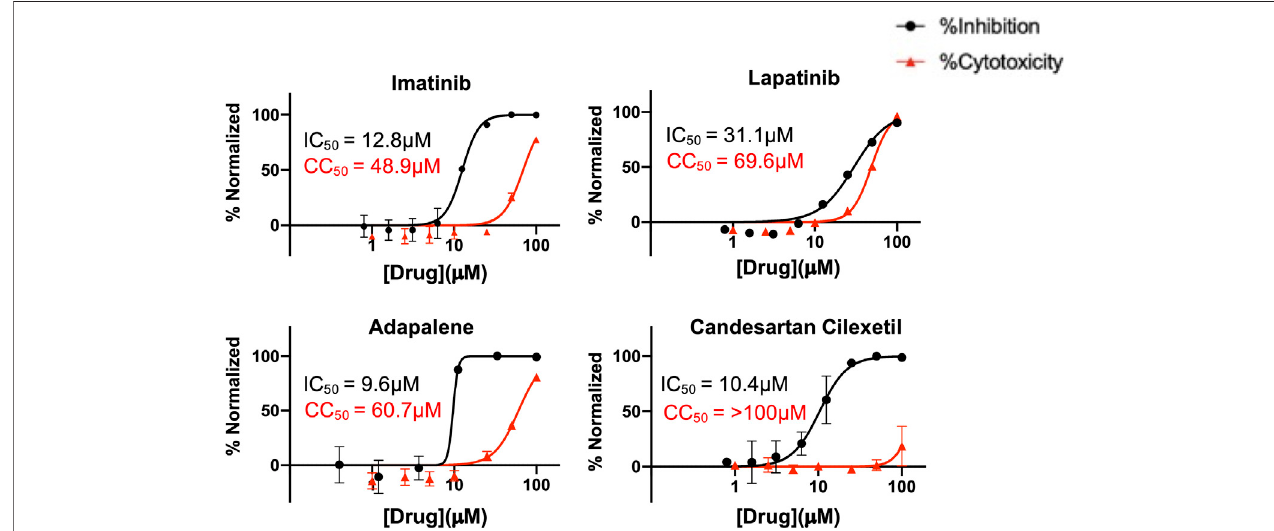
FIGURE6| PercentageinhibitionandpercentagecytotoxicitygraphsformSARS-CoV-2infectionstudiesthatshowlargetherapeuticindexesinthreehits.Varying concentrations of imatinib, lapatinib, and adapalene were used to treat virus for 30 min prior to infection in Vero cells, while candesartan cilexetil was added directly to cells without pre-treatment to virus. Infections were performed using SARS CoV-2mNeon at an MOI of 0.2. At 1 h post-infection, the media was removed and replaced with fresh media. Fluorescent reporter values were recorded 18 h post-infection. Similarly, Vero cells were treated with varying concentrations of indicated drugs, incubated for18 hpriortoanalysisbyPresto-Blue assaystoassess cytopathic effect.Datawerenormalized topercentinhibitionorpercentcytotoxicityfordrug-treated cells vs. no-treatment control. The values are means, with error bars displaying standard deviation between the triplicate wells. Half-maximal inhibitory concentration (IC 50 ) curves and values are represented in black while half-maximal cytotoxicity concentration 50 (CC 50 ) curves and values are represented in red.